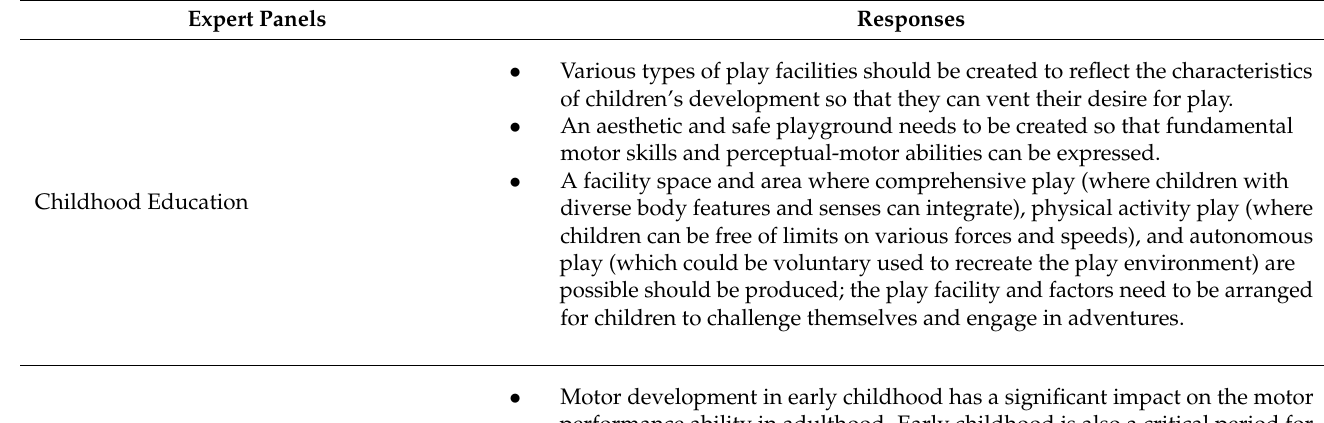
Table 4. Representative Response on Outdoor Playground Design Criteria